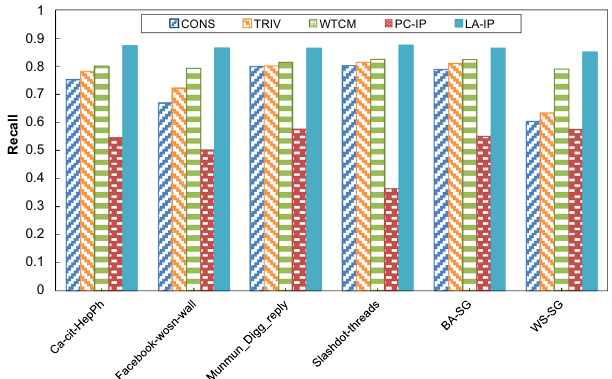
Figure 5. The results of the algorithms for prediction of influence probabilities with respect to recall.